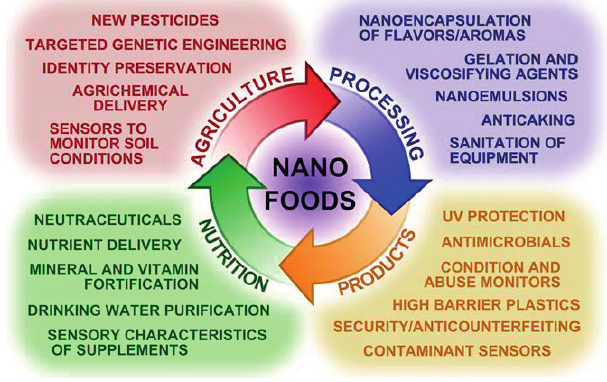
Figure 8. Some potential applications of nanotechnology in all areas of food science, from agriculture to food processing to security to packaging to nutrition and neutraceuticals. Reprinted with permission from Elsevier, 2011